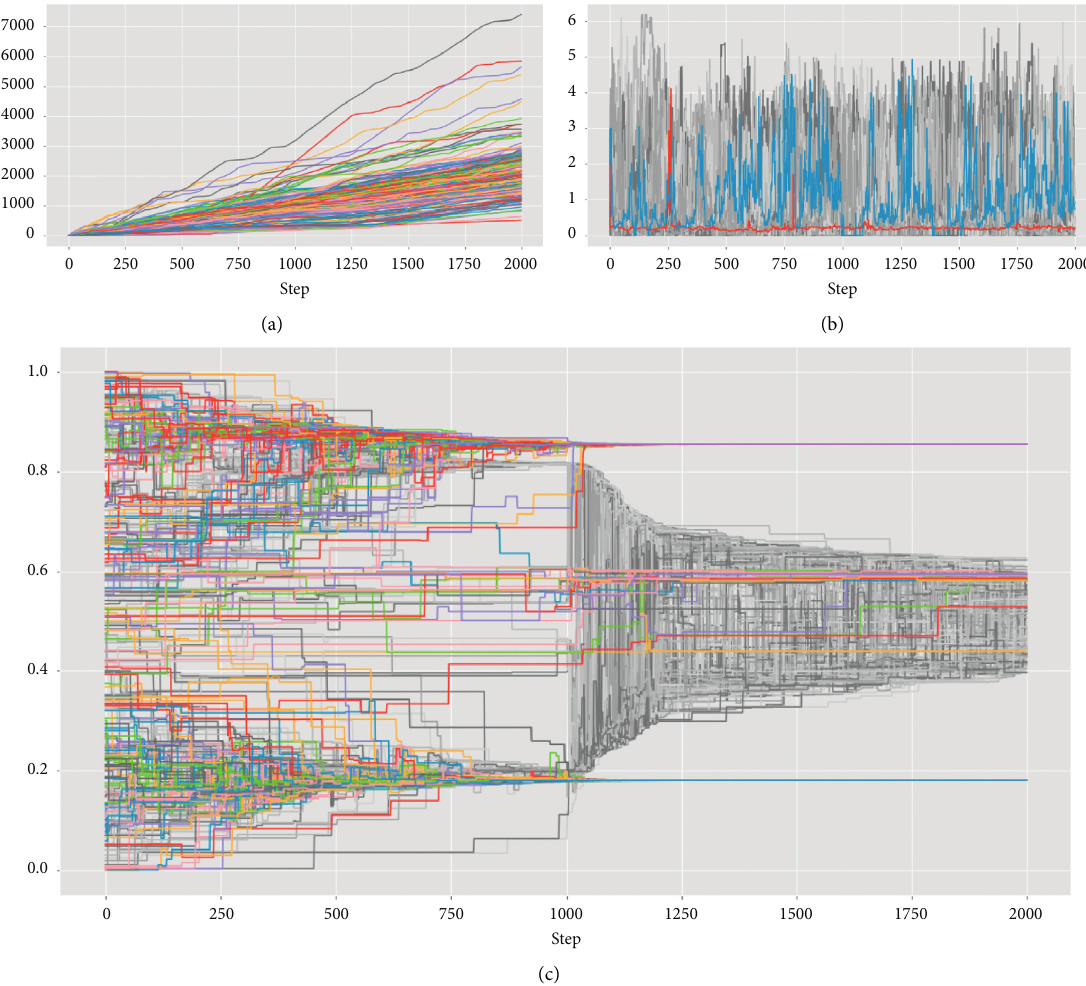
Figure 3: Behavior of baseline model: (a) cumulative PC of different actors over time, (b) PC over time with two highlighted individuals, and (c) opinion dynamics with (grey) and without (colored) focusing event. The focusing event started at time-step 1000 and lasted for 200 steps. During which all agents became more active and the convergence parameter was increased from 0.1 to 0.2. See the supplementary material for all model parameters of this